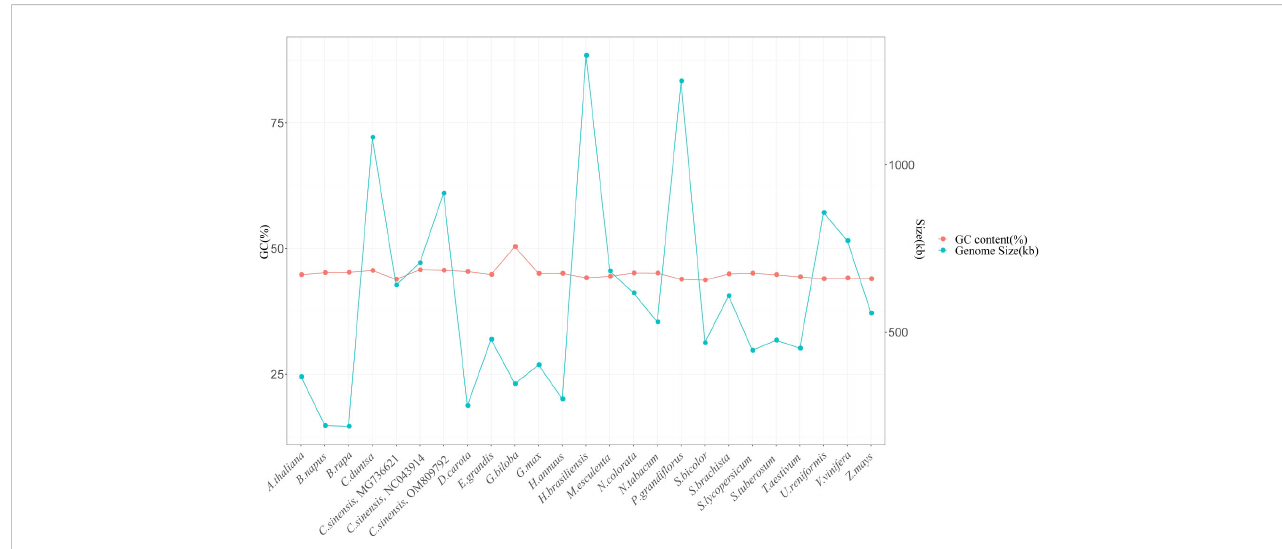
FIGURE 8 Gene content (GC) and genome size (kb) of twenty-four plant mitochondrial